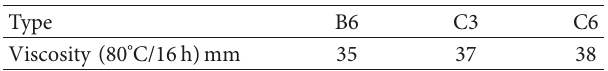
Figure 2: Variation in viscosity for different types of anchorage agents. Table 5: Thermal stability test.